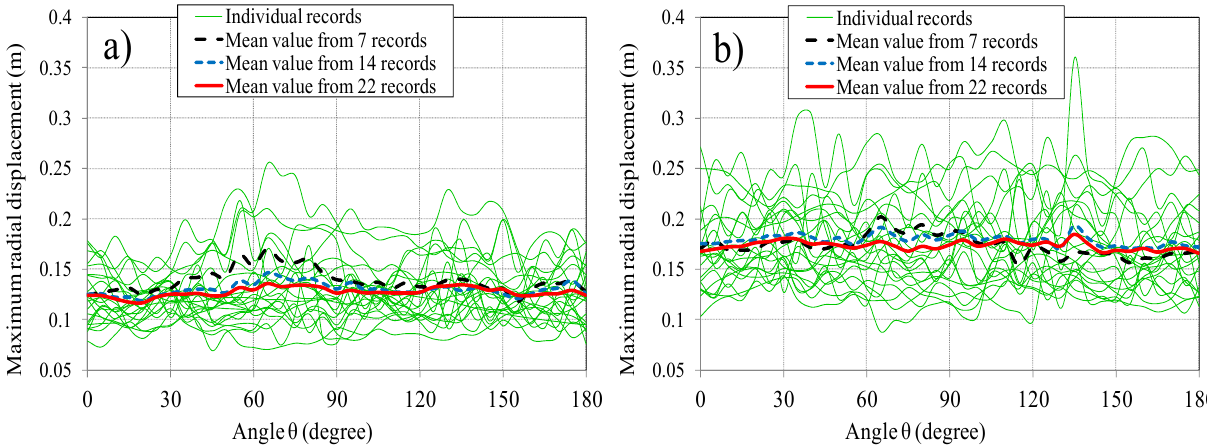
Figure 11. Maximum radial displacement of the critical central column for different records applied at different angles θ for ( a ) regular bridge; ( b ) irregular bridge.